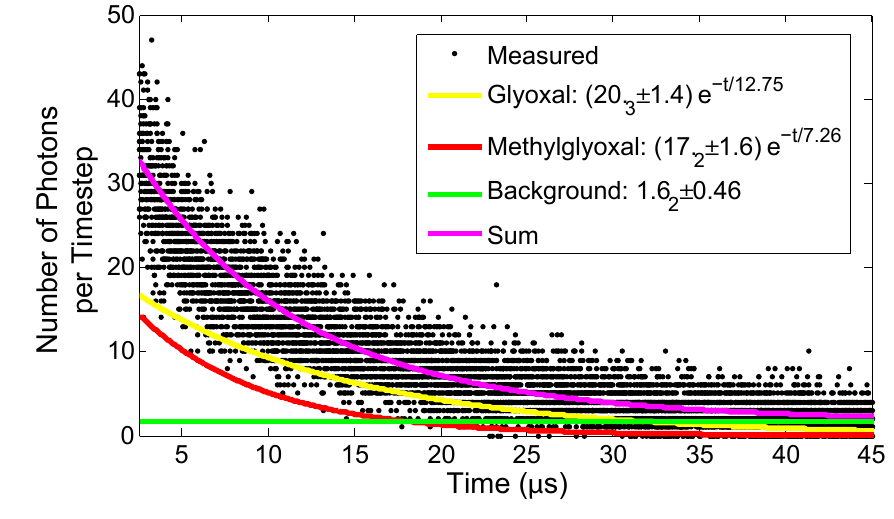
Fig. 4. Timestep in y-axis label corresponds to temporal resolution of Alazar data acquisition card (5.55ns). Decay of 5min integration for a mixture of glyoxal (180pptv) and methylglyoxal (2500pptv) taken with the Ti:Sapphire laser at λ T : S , H with line of best fit to Eq. (4) and its individual